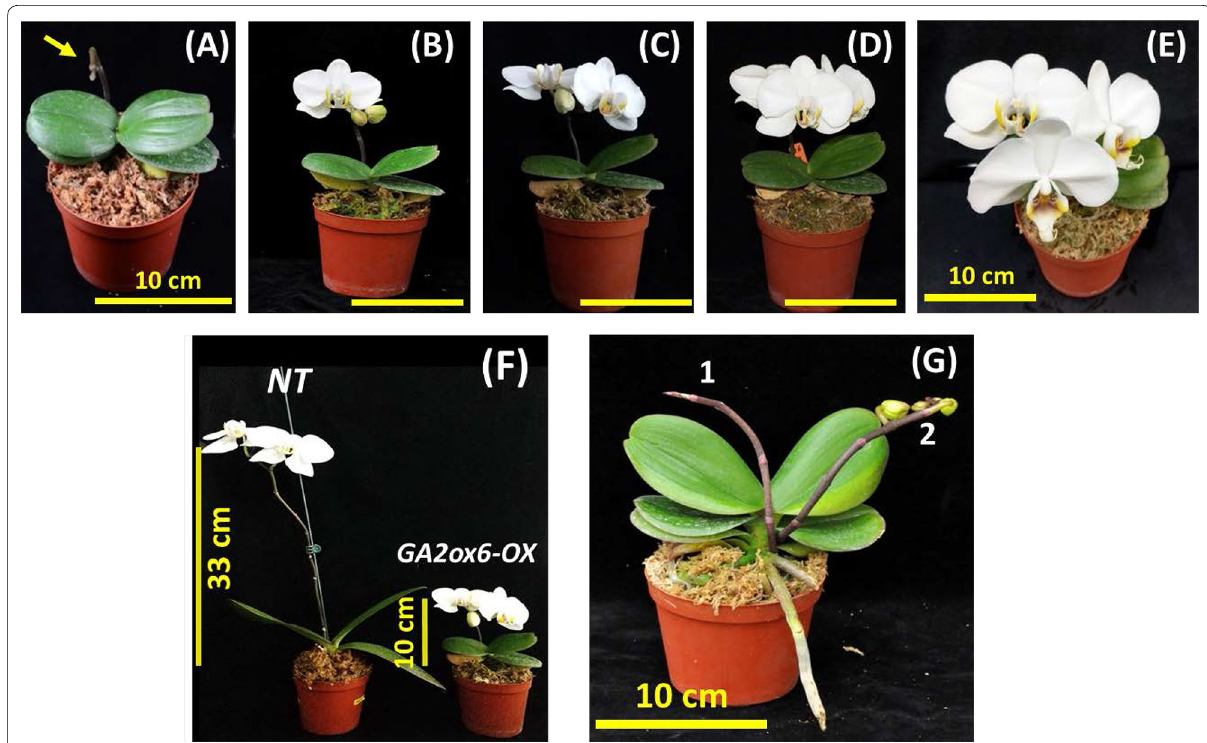
Fig. 5 Phenotypic comparisons of NT and GA2ox6 ‑ OX transgenic plants at the blooming stage. a The GA2ox6 ‑ OX transgenic plants bear a flower spike (inflorescence) indicated by a yellow arrow. b Blooming of the first flower bud. Bar 10 cm. c Blooming of the first two flower buds. = Bar 10 cm. d Blooming of all three flower buds. Bar 10 cm. e Top view of completely blooming GA2ox6 ‑ OX transgenic plants. f Comparison of NT = = and GA2ox6 ‑ OX transgenic plants at the blooming stage. The 33 cm flower spike length of the NT line and 10 cm spike length of GA2ox6 ‑ OX plants are indicated by yellow lines. g An example of a GA2ox6 ‑ OX transgenic line with two flower